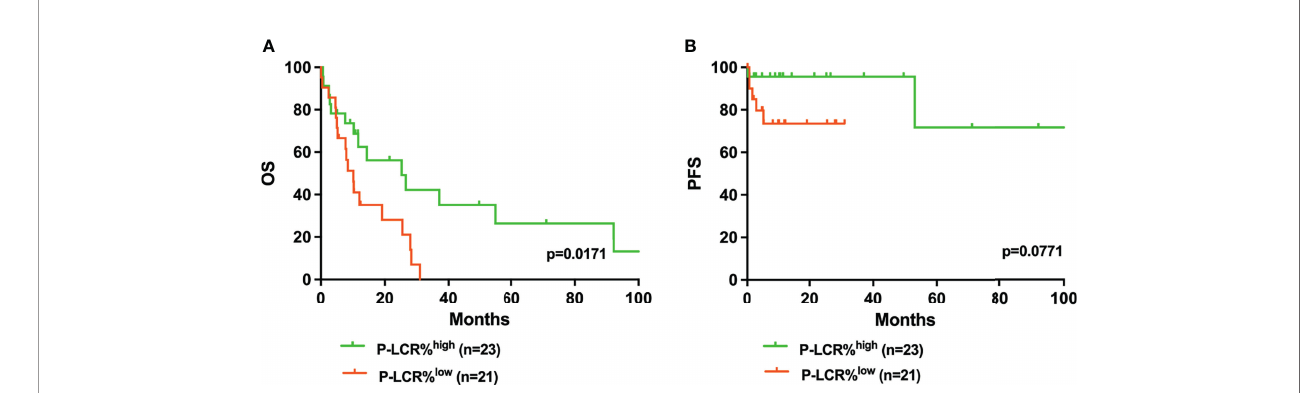
TABLE 2 | Univariate analyses for PFS and OS in 122 MDS patients in relation to prognostic parameters.